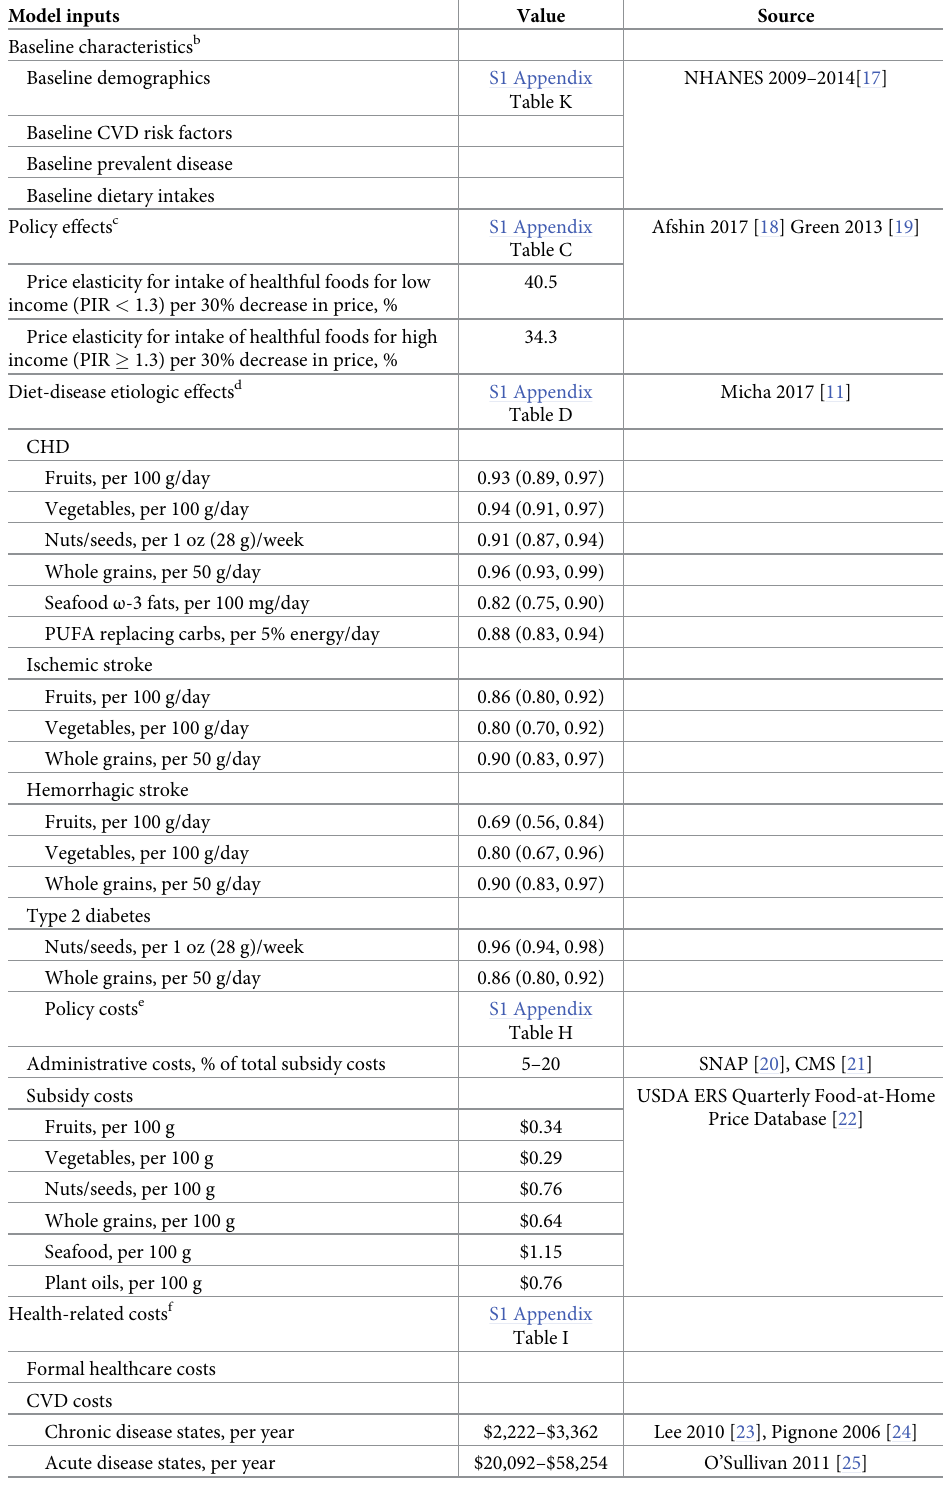
Table 1. Key model inputs and sources for cost-effectiveness analysis of financial incentives for improving diet and health through Medicare and Medicaid using the CVD-PREDICT model a